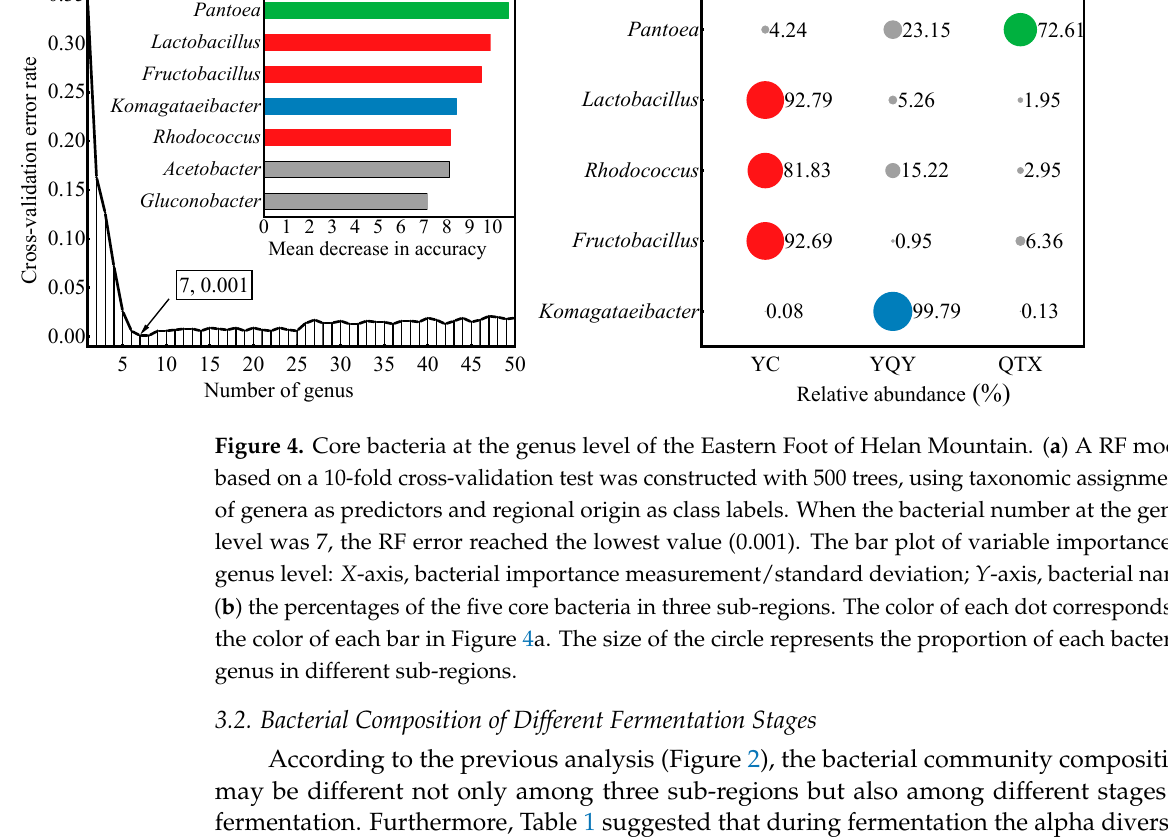
Table 1. Bacterial diversity in different fermentation